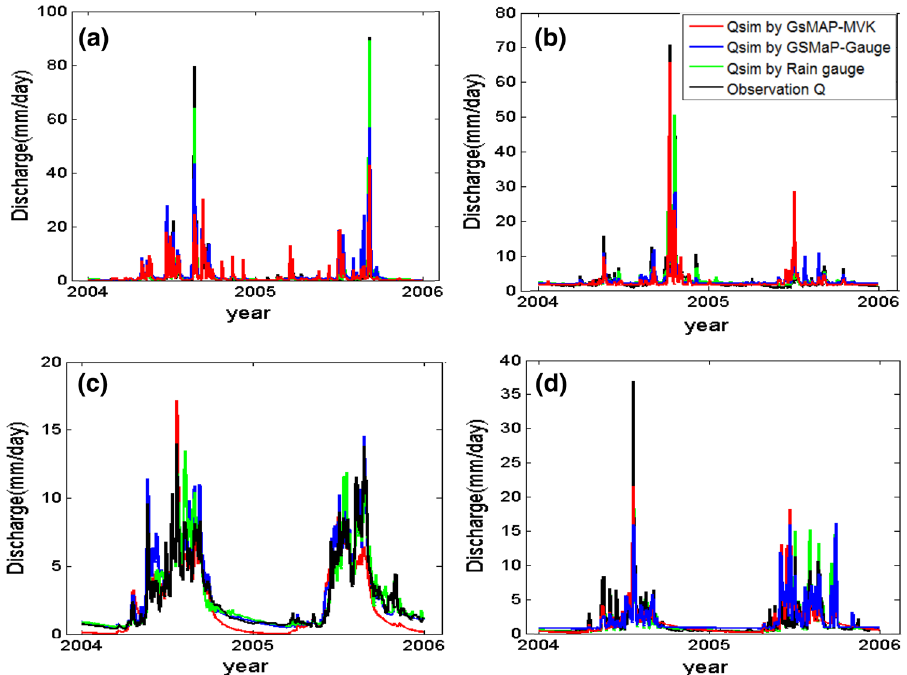
Fig. 14 Hydrograph of in a Hyeonsan, b Fuji, c Da, and d Upper-Cau during validation